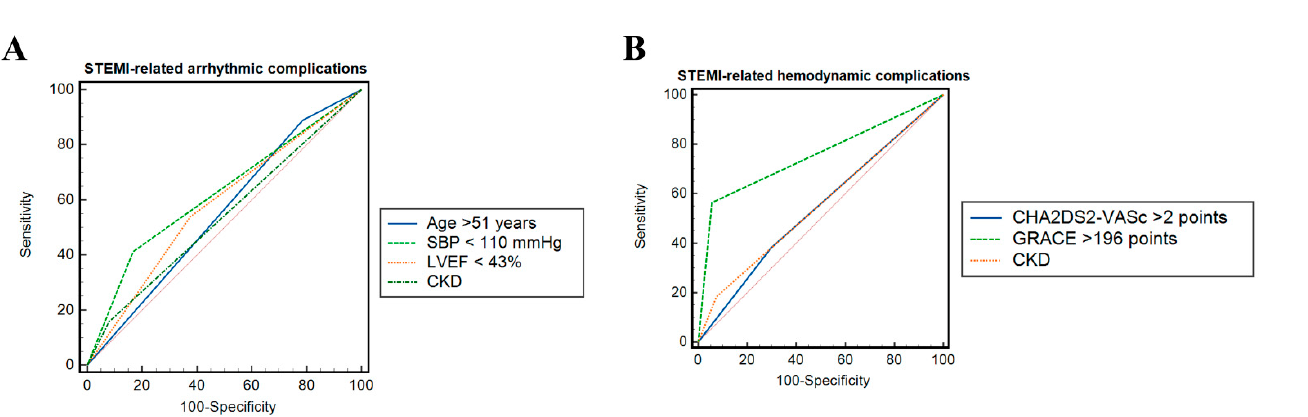
Figure 1. Comparison of receiver operating characteristic curves for predictors of ST-segment elevation myocardial infarction-related ( A ) arrhythmic complications and ( B ) hemodynamic complications. CKD—chronic kidney disease; LVEF—left ventricular ejection fraction; SBP—systolic blood pressure.